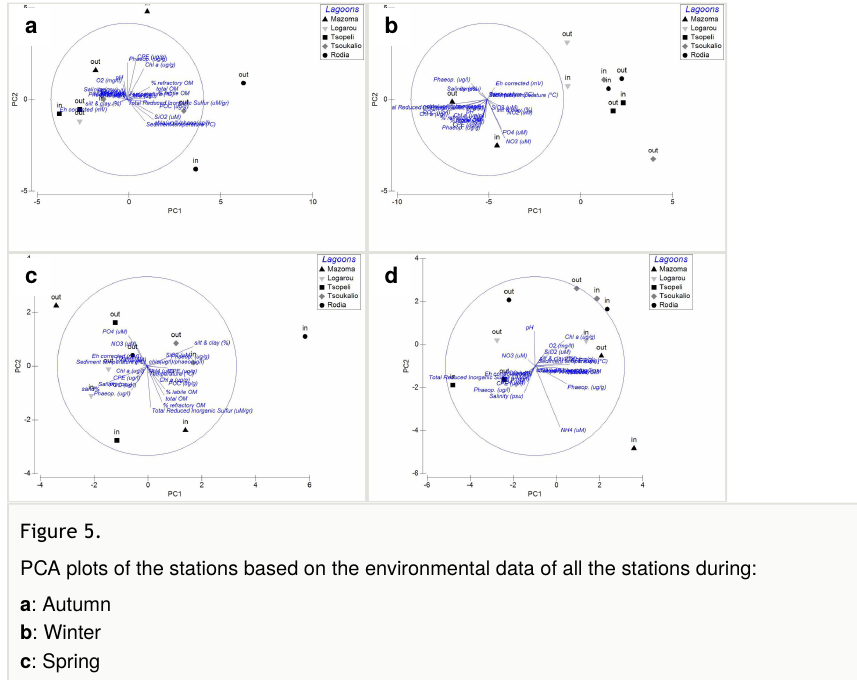
PCA plots of the stations based on the environmental data of all the stations